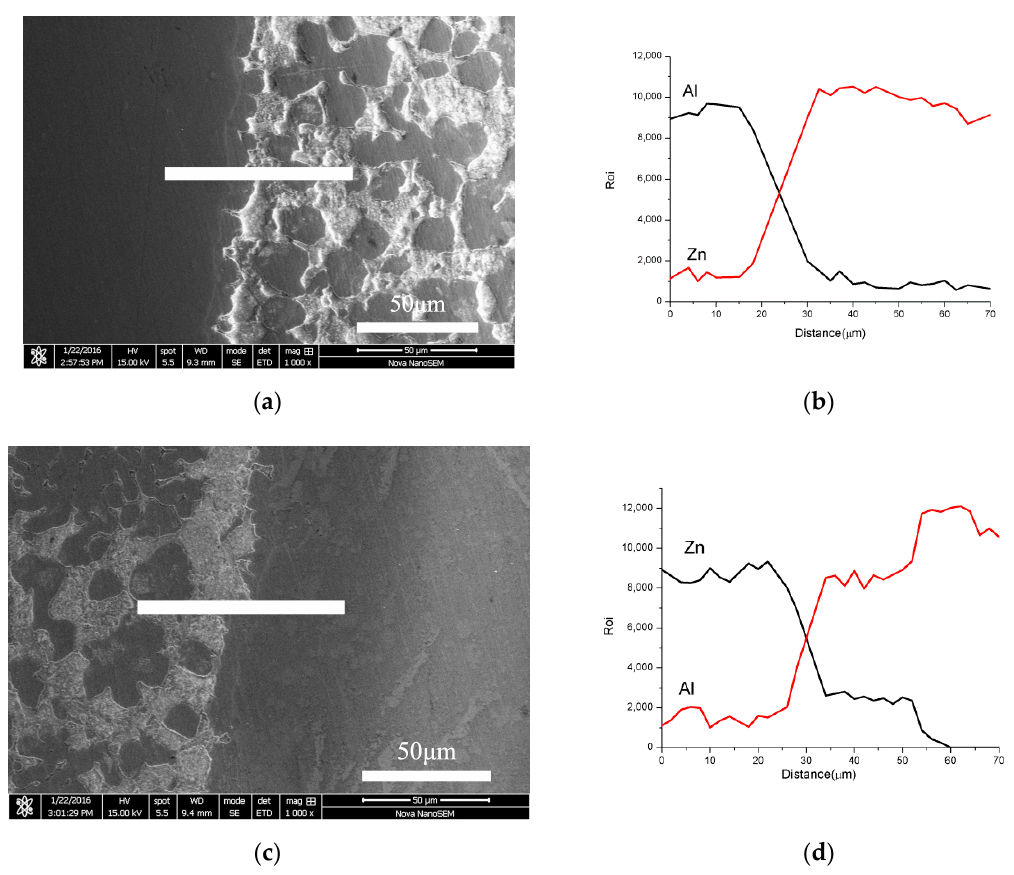
Figure 4. Scanning Electron Microscopy (SEM) images of a metallurgical joint ( a ) Interface of Al face sheet and Zn-10Al alloy ( b ) Energy Dispersive Spectroscopy (EDS) line analysis of Figure 4a ( c ) Interface of Zn-10Al alloy and Aluminum foam ( d ) EDS line analysis of Figure 4c.